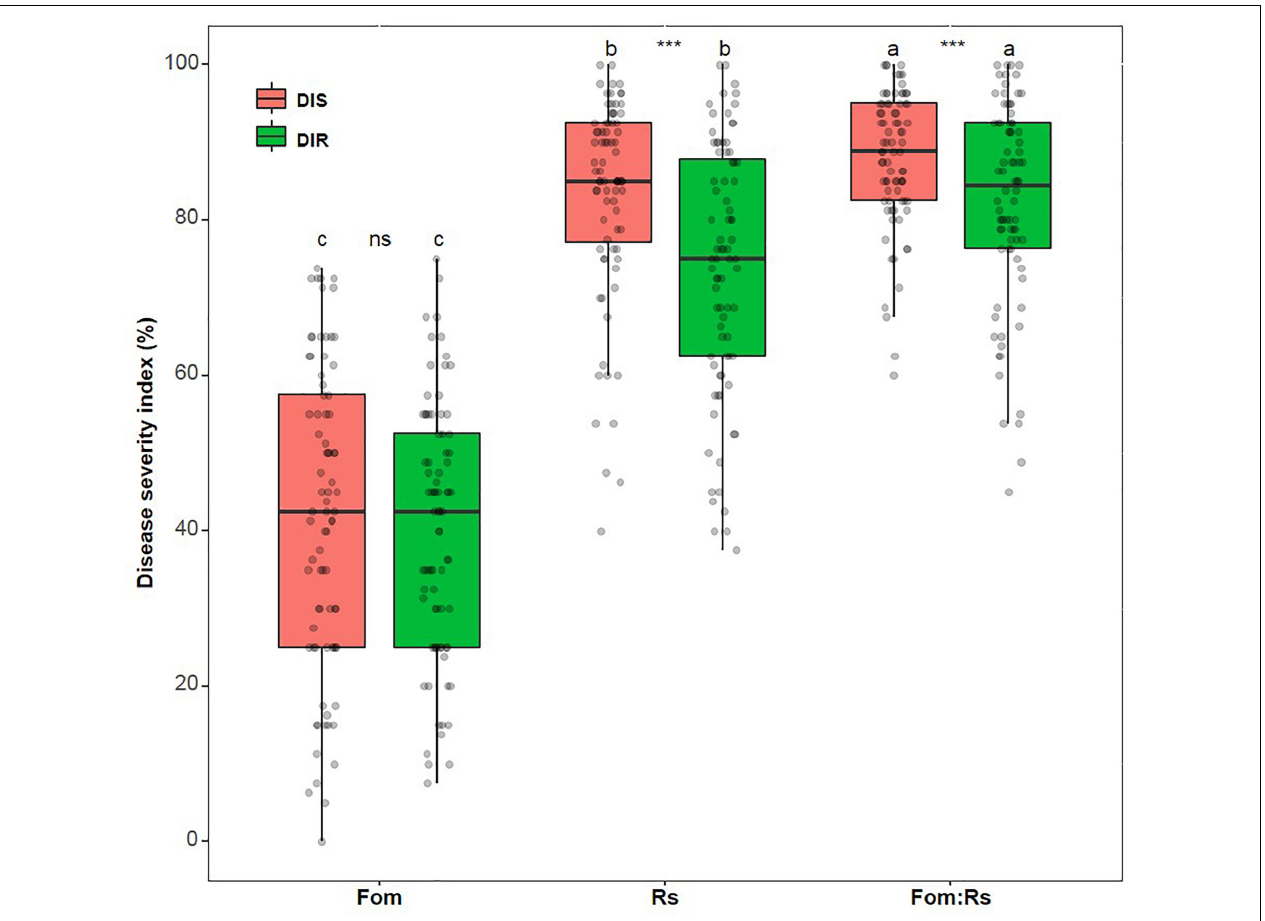
FIGURE 1 | Variations in disease severity among 80 alfalfa varieties single or co-inoculated with Fom and Rs. DIS and DIR, disease index of plant shoot and root, respectively. Fo, single inoculation with Fom; Rs, single inoculation with Rs; Fom:Rs, co-inoculation with Fom and Rs. Plants of the control treatment for companions showed no diseases and data were not included. Boxplots show the medians and 25th and 75th percentiles, with whiskers extending to 1.5 times of the interquartile range, and data presented beyond whiskers represent outliers. Different letters above the bars in the same column indicate significant differences ( p < 0.001) among treatments according to Fisher’s protected least significant difference (LSD) test. Asterisks between the bars under the same treatment indicate a significant difference ( p < 0.001) between traits by Student’s t -test. ns, not significant between